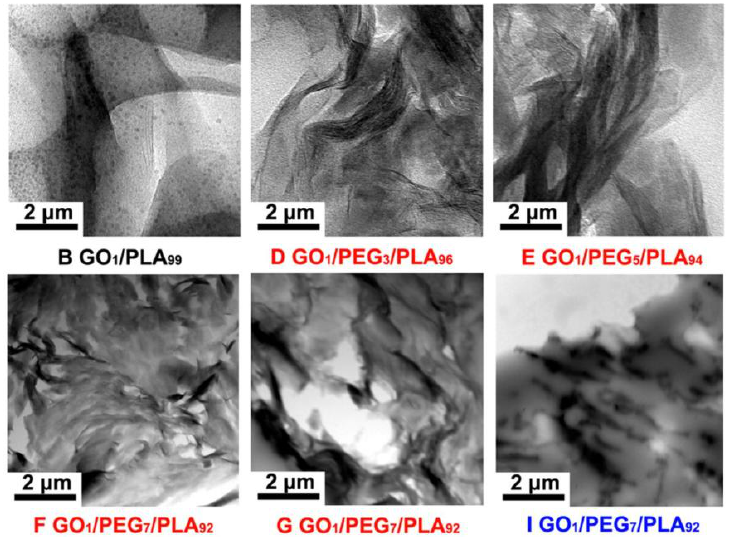
Figure 4. Transmission electron microscopy (TEM) images of GO/PLA and GO/PEG/PLA Transmission electron microscopy (TEM) images of GO/PLA and multi-phase composites with the introduction of GO/PEG of different component ratios under different melt-compounding.